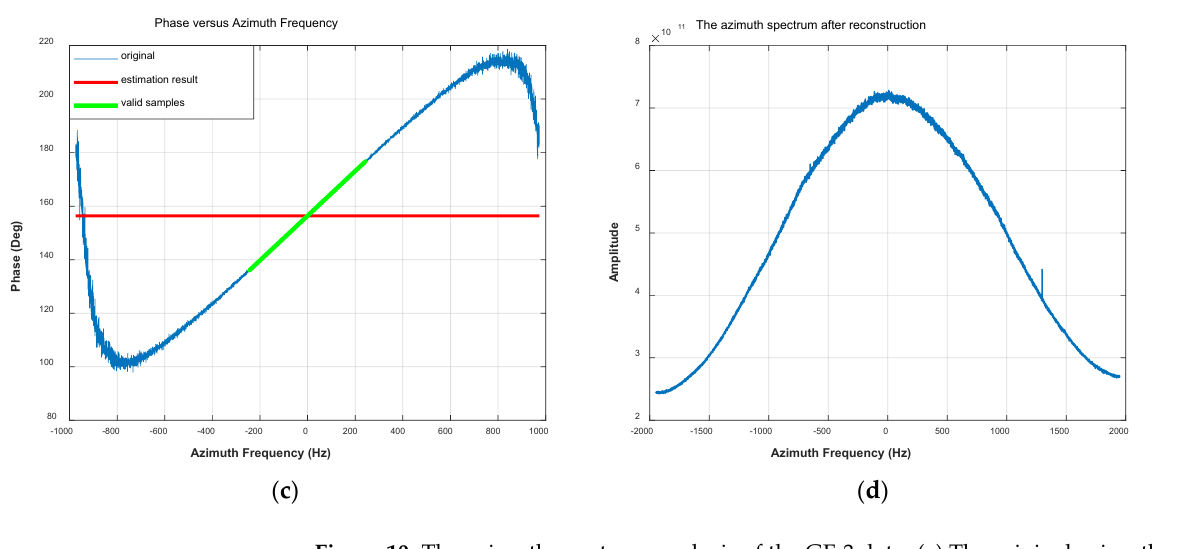
Figure 10. The azimuth spectrum analysis of the GF-3 data. ( a ) The original azimuth spectrums of the GF-3 data, where the blue line and red line correspond to the first channel and second channel, respectively. ( b ) The azimuth spectrum after the Doppler centroid compensation. ( c ) The phase versus azimuth frequency and the estimation result of phase imbalance by FCM. ( d ) The azimuth spectrum of the GF-3 data after preprocessing and reconstruction.